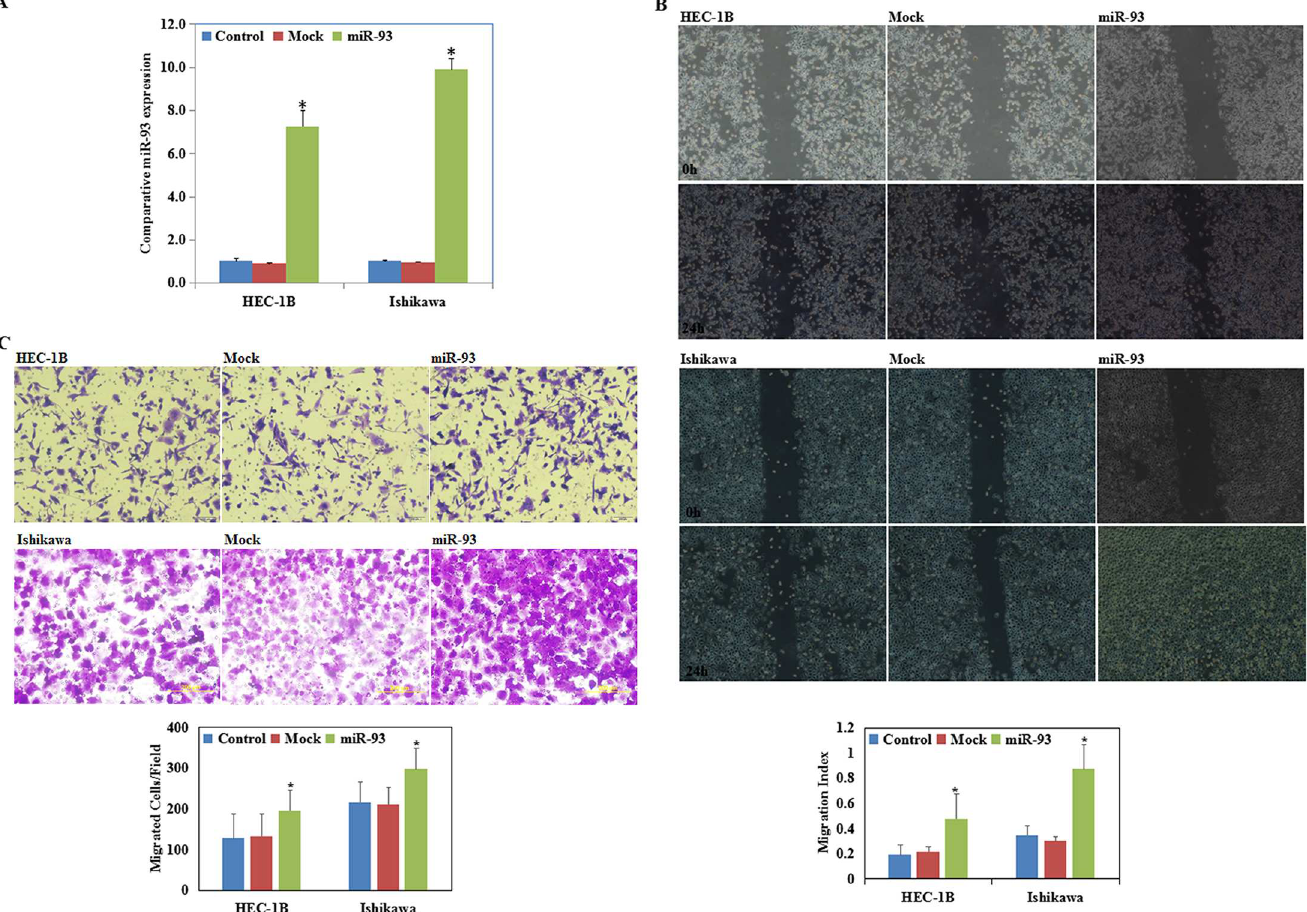
Fig 2. MiR-93 transfection promoted endometrial carcinoma cell migration and invasion. FollowingmiR-93 transfection, miR-93 levels were significantly increased (A) , endometrial carcinomacell lines exhibitedfaster migration (B) , and strongerinvasion (C) comparedwith the control and mock cells 24 hours after transfection. Three representative microscopic fields were photographed to quantify the extent of invasionand migration,and three independentexperiments were performed.Results are representative of three separate experiments; data are expressedas the mean ± standard deviation, * P <